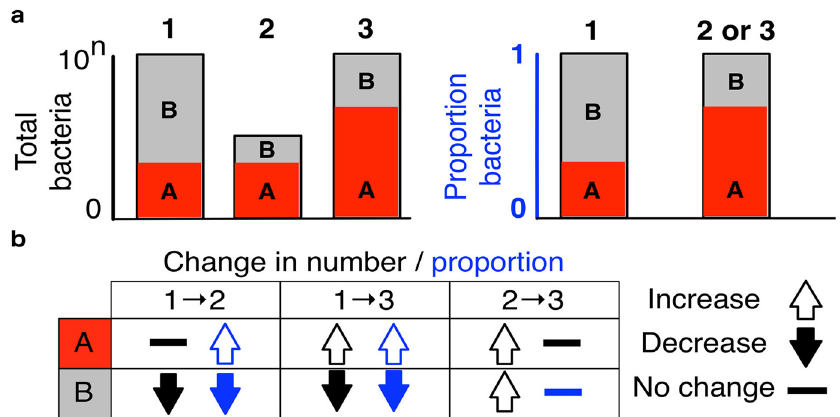
Figure 2. Gut metagenome sequencing data are compositional. In this illustration, we observe three samples (1, 2 and, 3) and two microbial species (A and B). The sequence counts of microbial samples do not provide information about the absolute microbial abundances (black) making the observed data inherently compositional (blue). Therefore, real change in the total abundance of one microbial species can impose perceived change in other observed species (bottom left). Conversely, multiple proportionate changes in the real microbial abundances may be hidden from the observed abundances (bottom right). Adapted from Gloor et al. [43]. Licensed under Creative Commons Attribution License (CC BY,